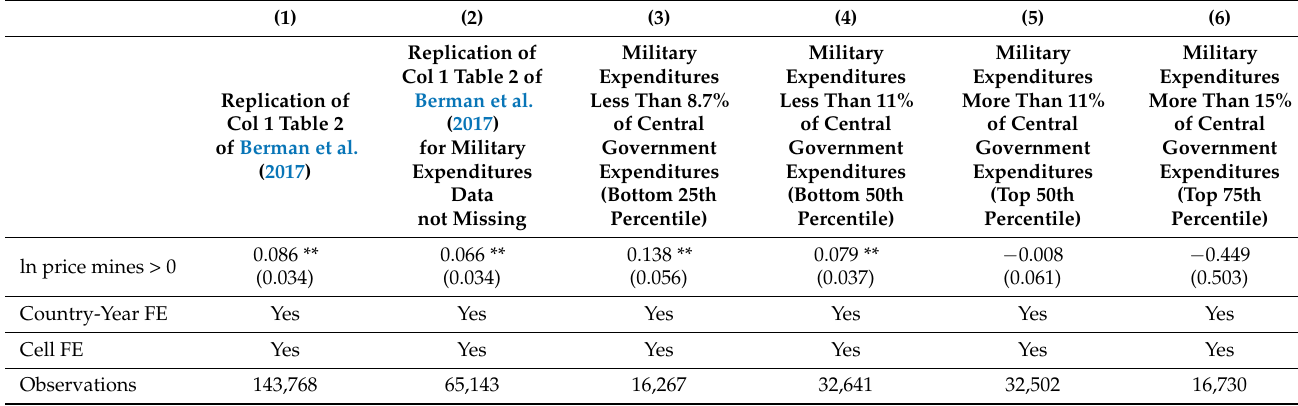
Table A5. Berman, Couttenier, Rohner, and Thoenig (Berman et al. 2017). “This Mine is Mine: How Minerals Fuel Conflicts in Africa”.